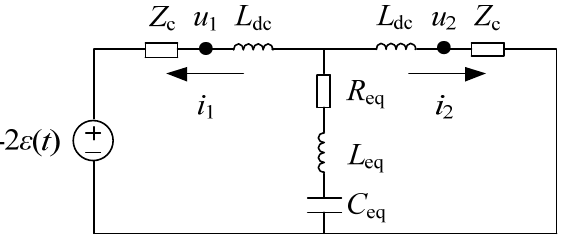
Figure 3. Peterson equivalent circuit.